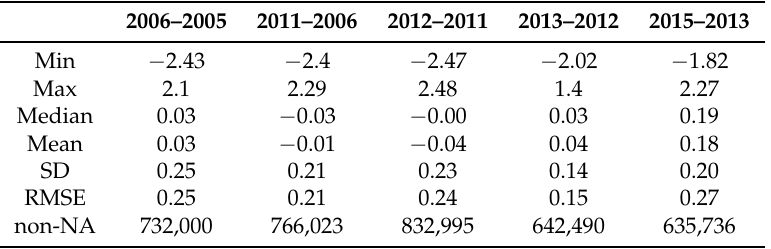
Table 3. Vertical differences (in meters) between successive pairs of DEMs in stable areas around the rock glacier (sub-vertical rock face, flat Quaternary moraine and gently inclined fossil rock glacier).